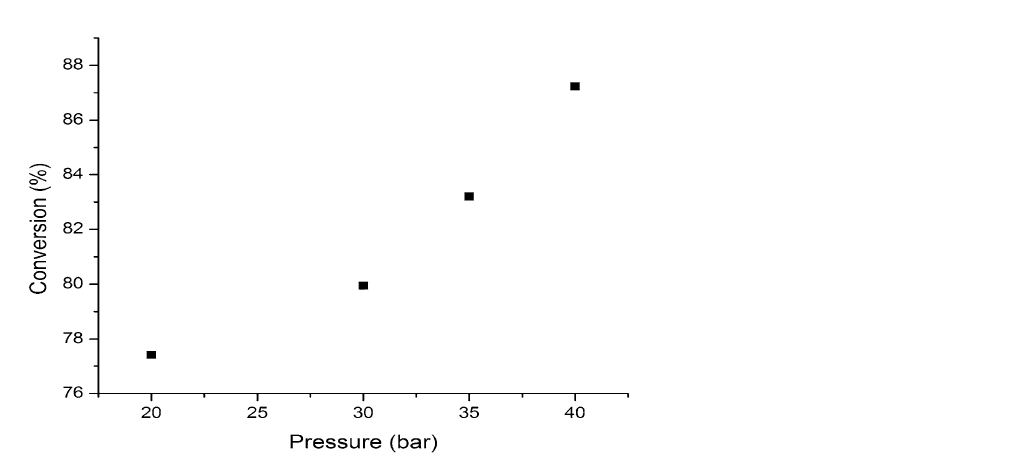
Figure 9. The influence of temperature over bio-oil